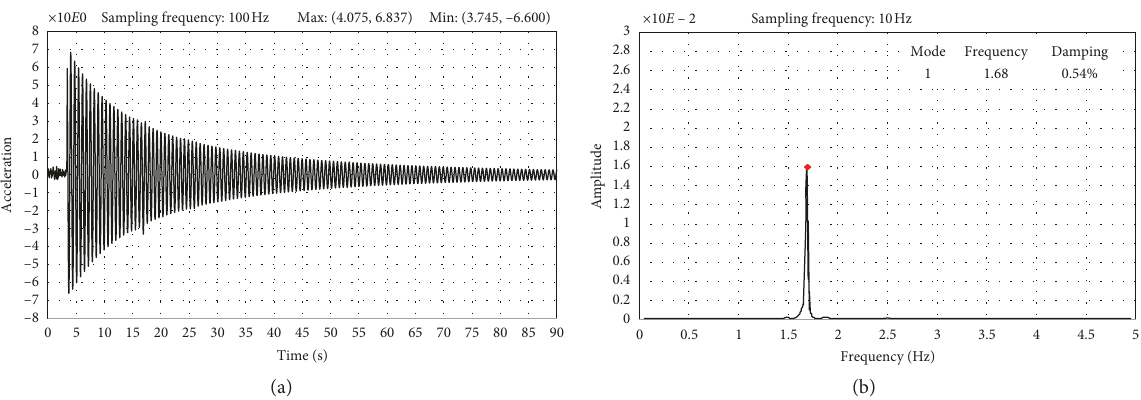
Figure 20: Monitoring results with the particle damper (19 glass balls in container). (a) Acceleration-time history curve of the frame. (b) Identified frequency and damping ratio.